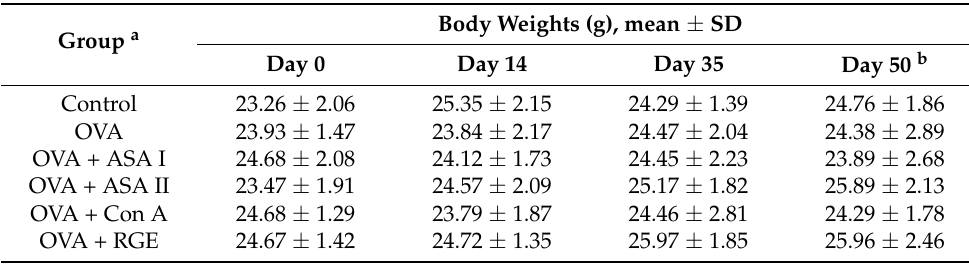
Table 4. Body weights of BALB/c mice at different intervals of time after antigen administration by intranasal route in adjuvanticity